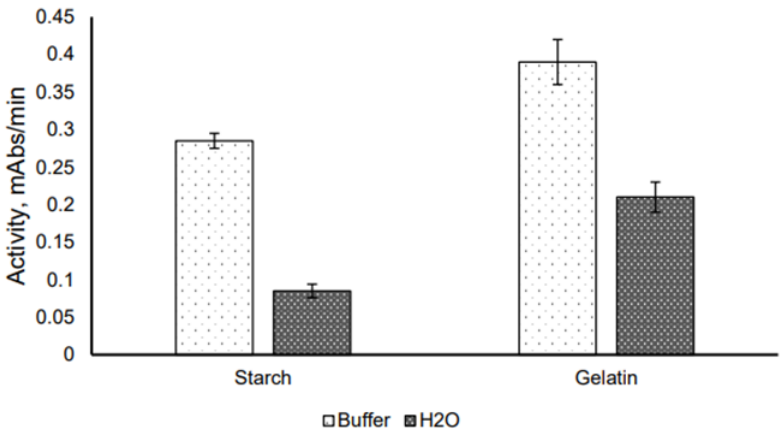
Figure 4. Activity of BChE co-immobilized with DTNB in the 3% starch gel or 1.4% gelatin gel in different control solutions. Each preparation disk contained 0.11 U of BChE and 0.2 mM DTNB.